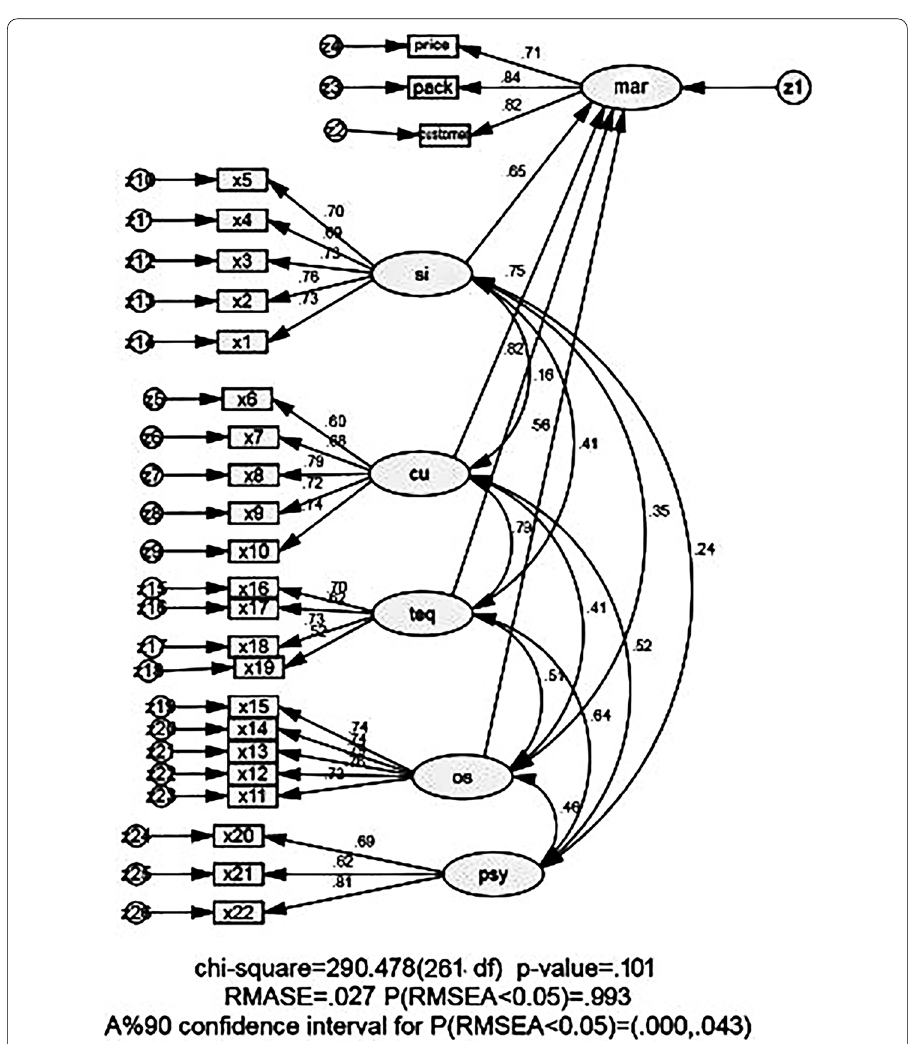
Fig. 2 Path diagram of the research